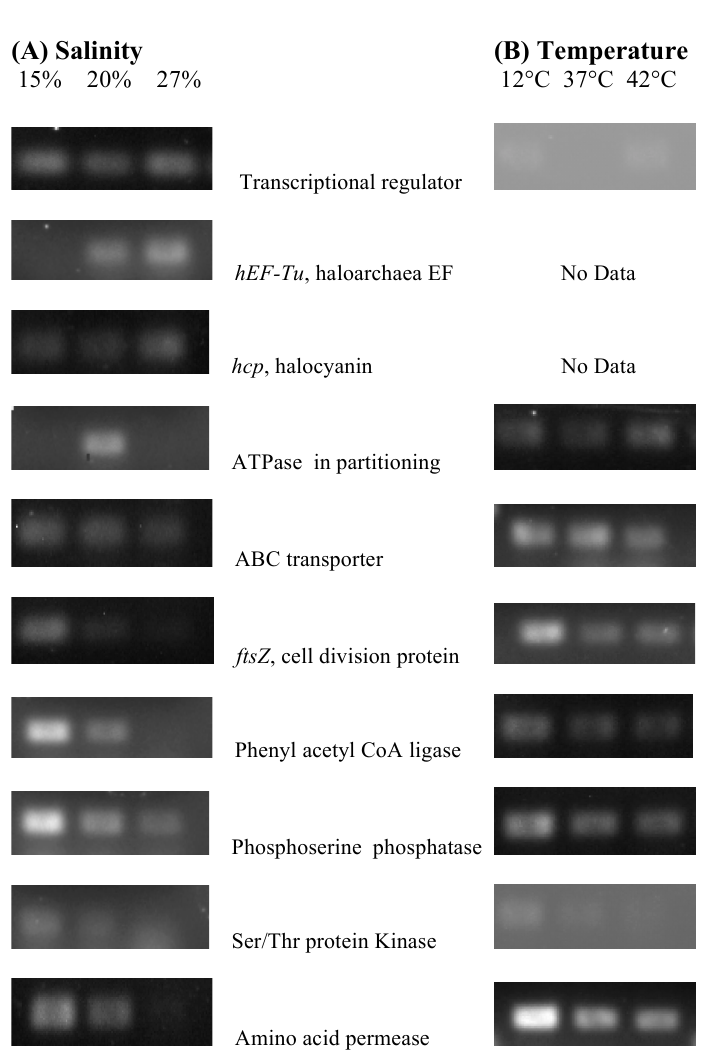
Figure 3. Confirmation of differential gene expression of RAP-PCR fragments in NA6-27 grown under the following conditions. ( A ) Salinity 15%, 20%, and 27% NaCl (w/v) and ( B ) Temperature 12, 37 and 42 ◦ C. Quantitative PCR was performed using gene specific primers as described by Benson et al. [21,22,39]. Gel documentation photographs are aligned with data on genes for each growth condition. Table 3. GenBank gene sequence matches for RNA arbitrarily primed -PCR products.